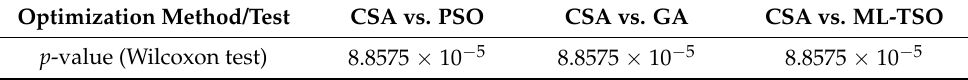
Table 7. Wilcoxon’s rank-sum test for the 118-bus test network. Optimization Method/Test CSA vs. PSO CSA vs. GA CSA vs.